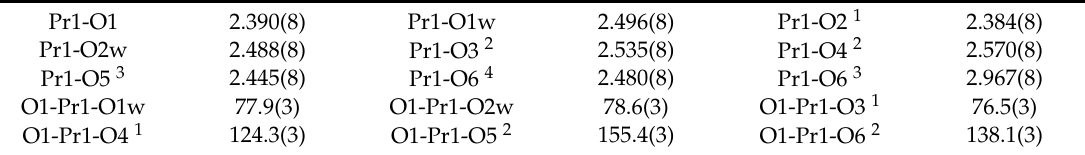
Table 2. Selected bond lengths (Å) and angles ( ◦ ) for complex 1 .